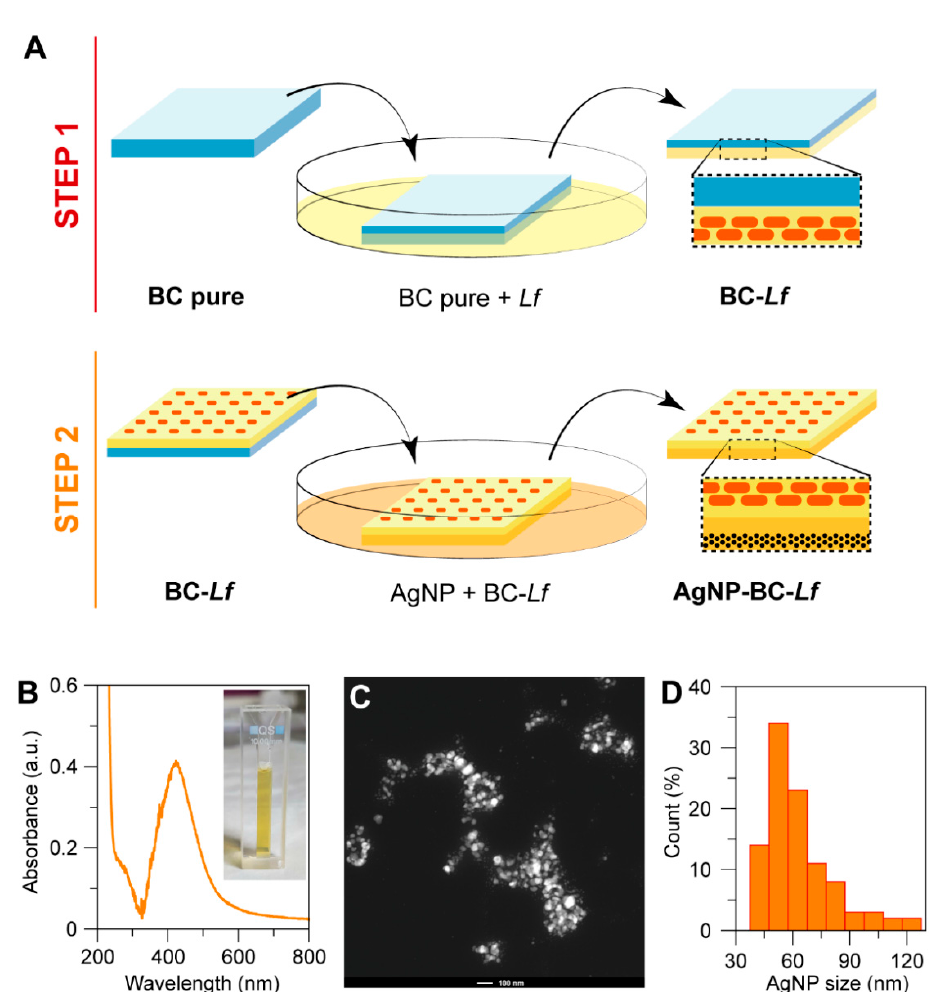
Figure 1. ( A ) Graphical representation of the experimental protocol used to obtain the two-sided BC. The first step involves the adsorption of probiotics followed by the impregnation of the opposite BC side with AgNPs. The resulting material is referred to as AgNPs-BC- Lf . ( B ) The UV-vis spectrum showed the expected absorbance band centered at 420 nm, in agreement with AgNPs with a mean diameter of 50 nm. The inset in B corresponds to a picture of an AgNPs solution. ( C ) HAADF-STEM micrograph of AgNPs (scale bar is 100 nm). ( D ) Diameter distribution of AgNPs (n = 100).